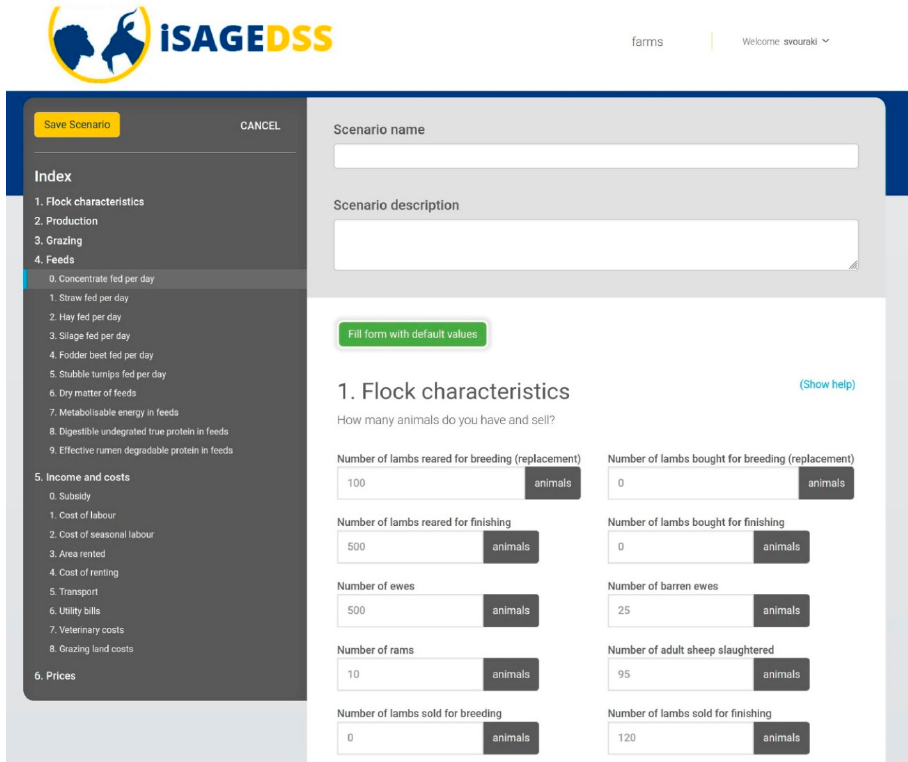
Figure 4. Scenario data input form; users are asked to provide data in terms of flock size, production goals, feeding, grazing, incomes and costs and prices, using a simple web